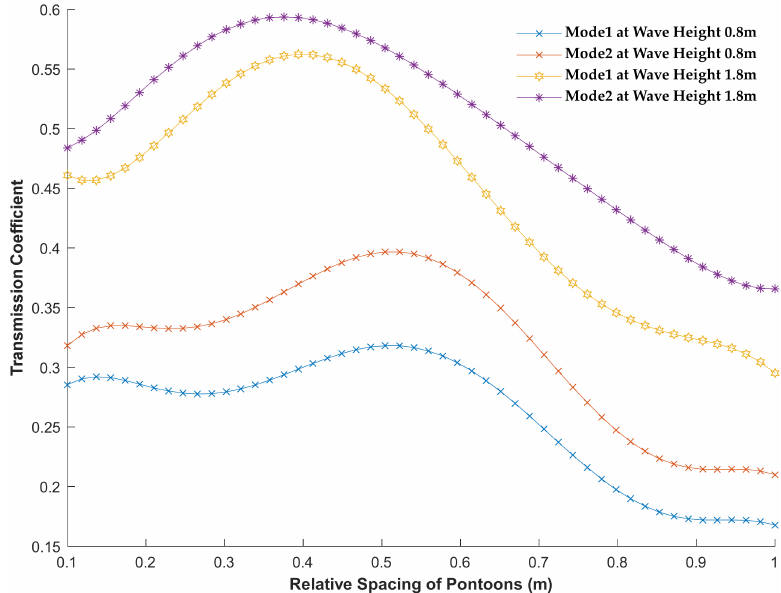
Figure 13. Transmission coefficient of the two